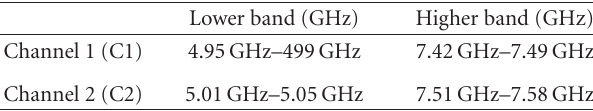
Table 1: Operating frequency